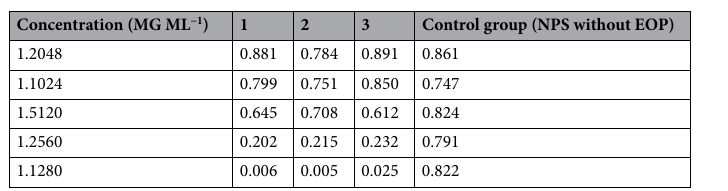
Table 1. Light absorption of the 4 groups for MTT solution in a period of 24 h. Each drug concentration was repeated three